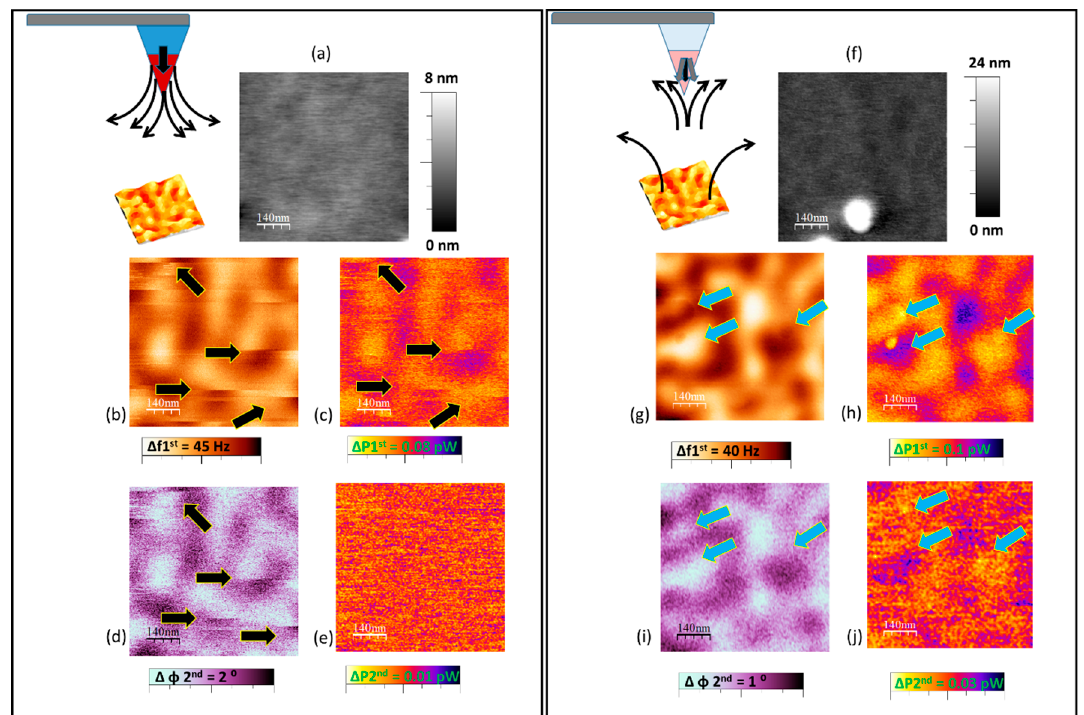
Figure 2. Different tip-sample interactions. Left panel corresponds to a Bimodal MDFM experiment with a high moment magnetic tip and right panel corresponds to a similar experiment with a low moment MFM tip: ( a – f ) topography of the sample (CoCr film), ( b , g )frequency shift of the first mode during the second scan where the magnetic signal is detected. ( d , i ) phase of the second mode during the retrace scan. ( c , h ) are the dissipation maps calculated with Equation (1) and the parameters corre- sponding to the 1st mode ( e , j ) are the dissipation maps of the 2nd mode. All the dissipation maps are calculated during the retrace scan. The black arrows indicate tip induced magnetic reversal whereas blue arrows indicate dissipation-related features due to spin canting at the tip apex. Images size: 0.7 μ m × 0.7 μ m. A 1 = 20 nm. A 2 = 0.75 nm. Z lift distance = 30 nm.